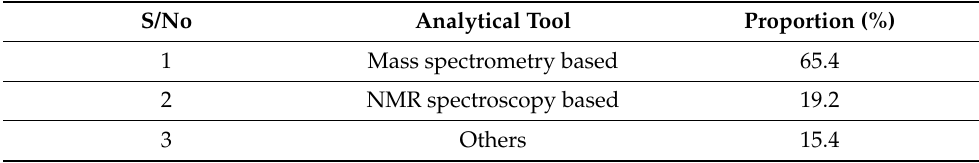
Table 1. The proportion of analytical tools that were employed in the included